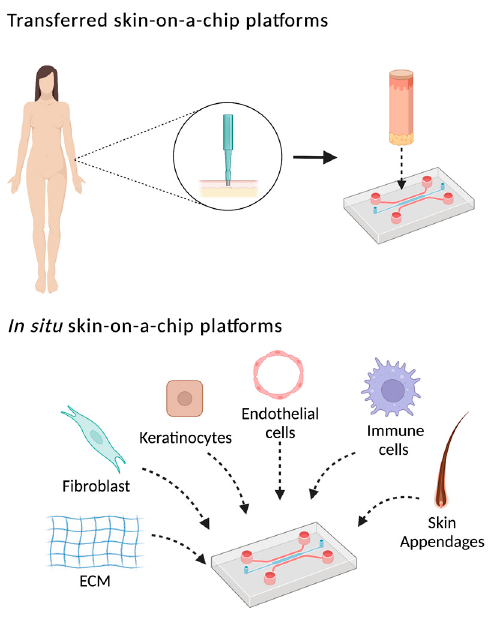
Figure 2. Schematic representation of SoC approaches. Created with BioRender.com.